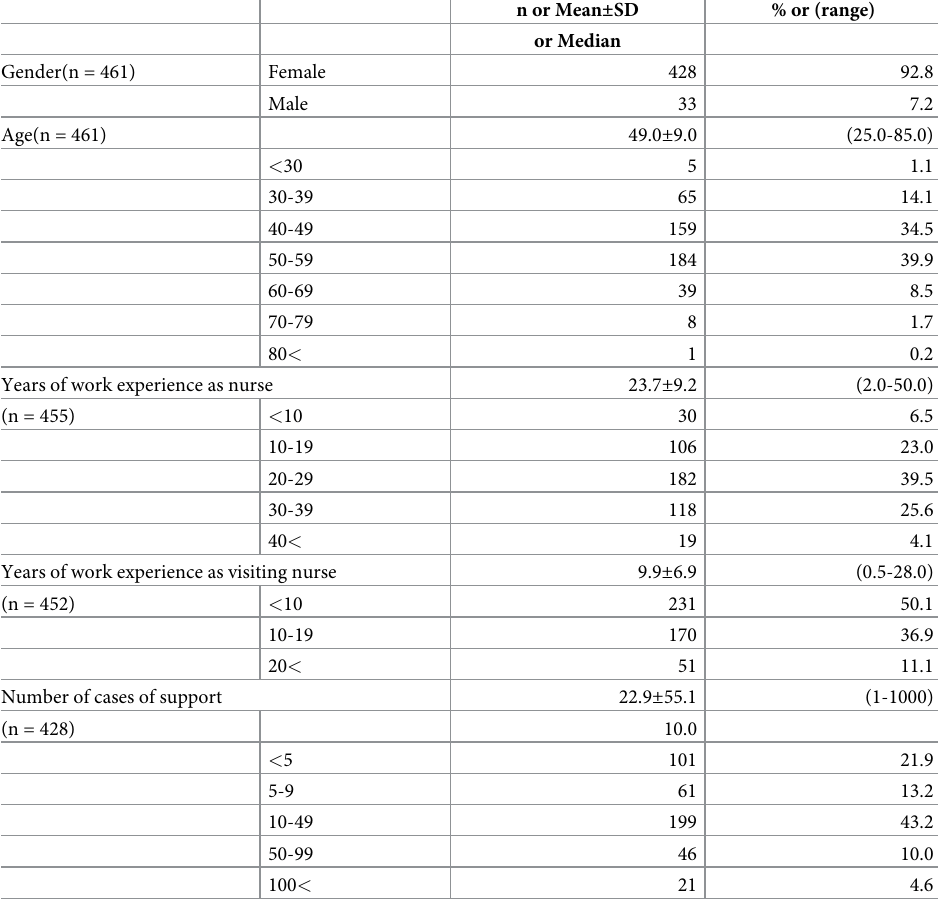
Missing data were excluded from each